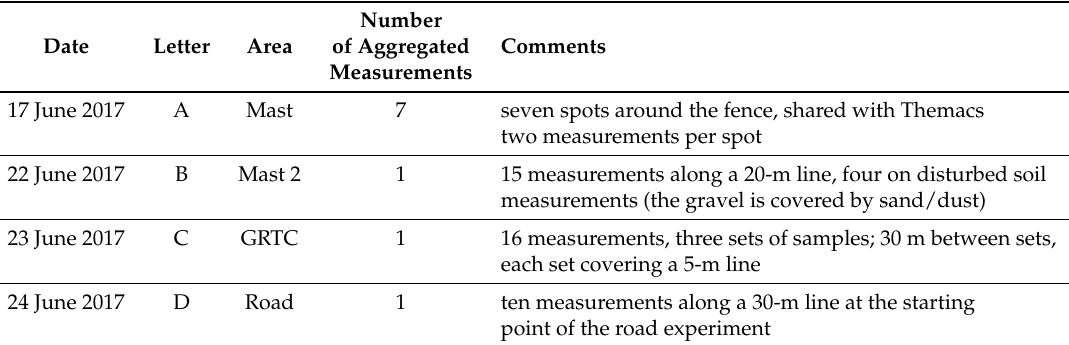
Table 4. Description of the ground based emissivity measurements.